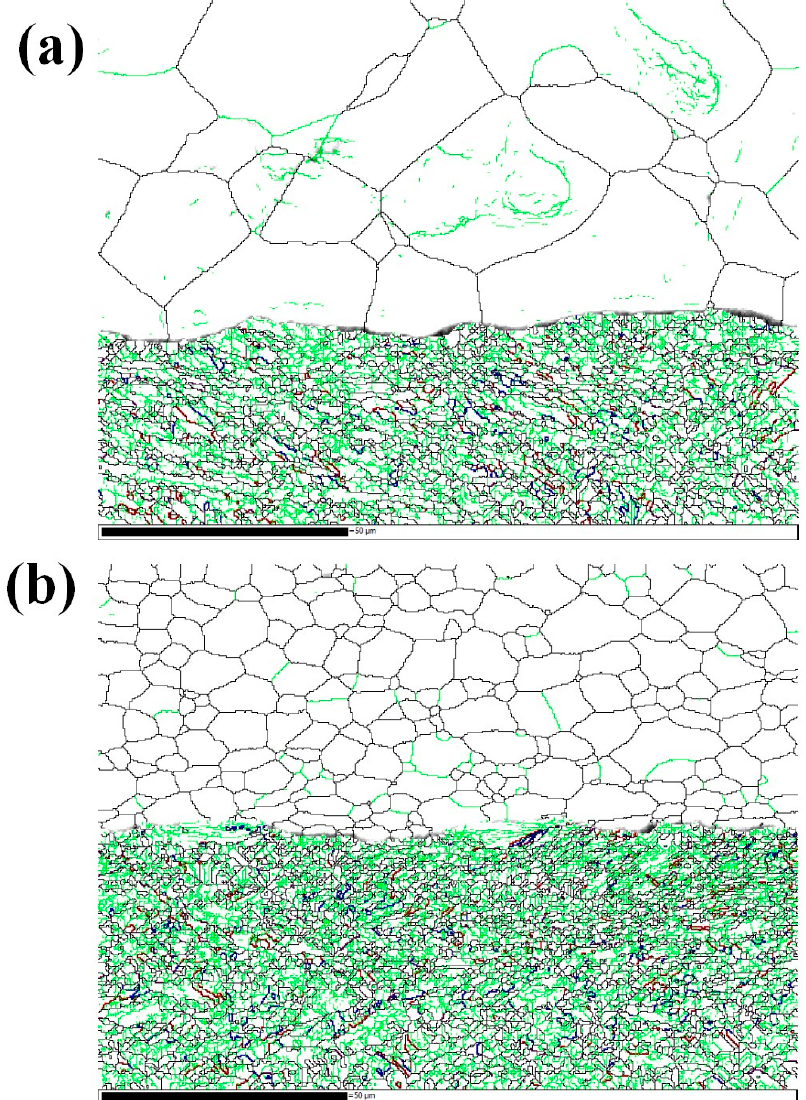
Figure 17. EBSD grain boundaries near the interface. ( a ) Specimen B3; ( b ) specimen C3. Lime green, black, red, blue and purple correspond to LAGBs (2° < misorientation angle < 15°), HAGBs (misorientation angle > 15°), 65° <011 0> boundaries, 85° <1 21 0> boundaries and 45° <51 4 3> boundaries, respectively.